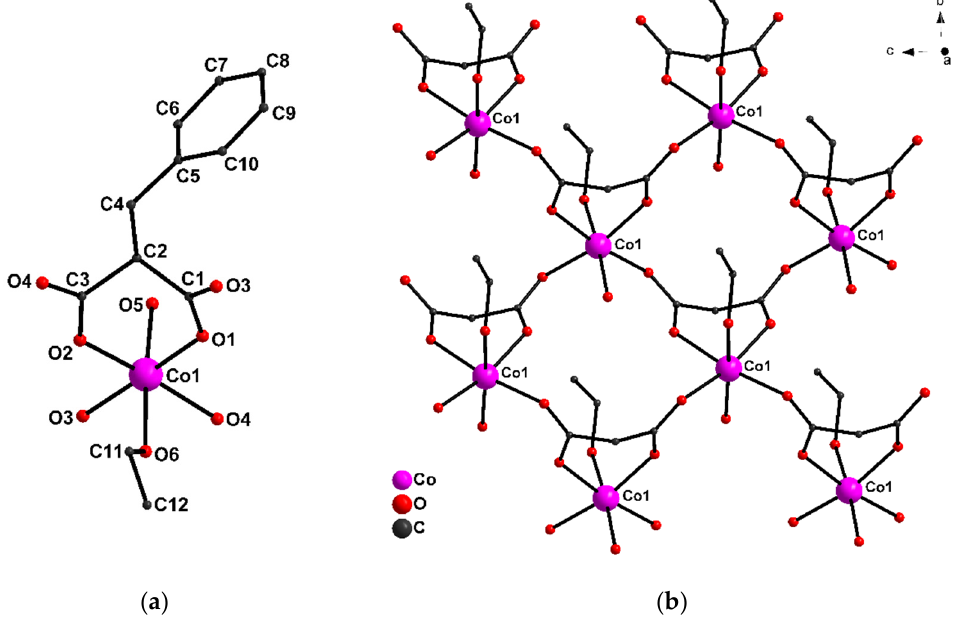
Figure 1. Fragment of Complex 1 ( a ); fragment of polymeric layer of 1 ( b ). (Hydrogen atoms and benzylmalonate substituents in b are omitted for clarity).